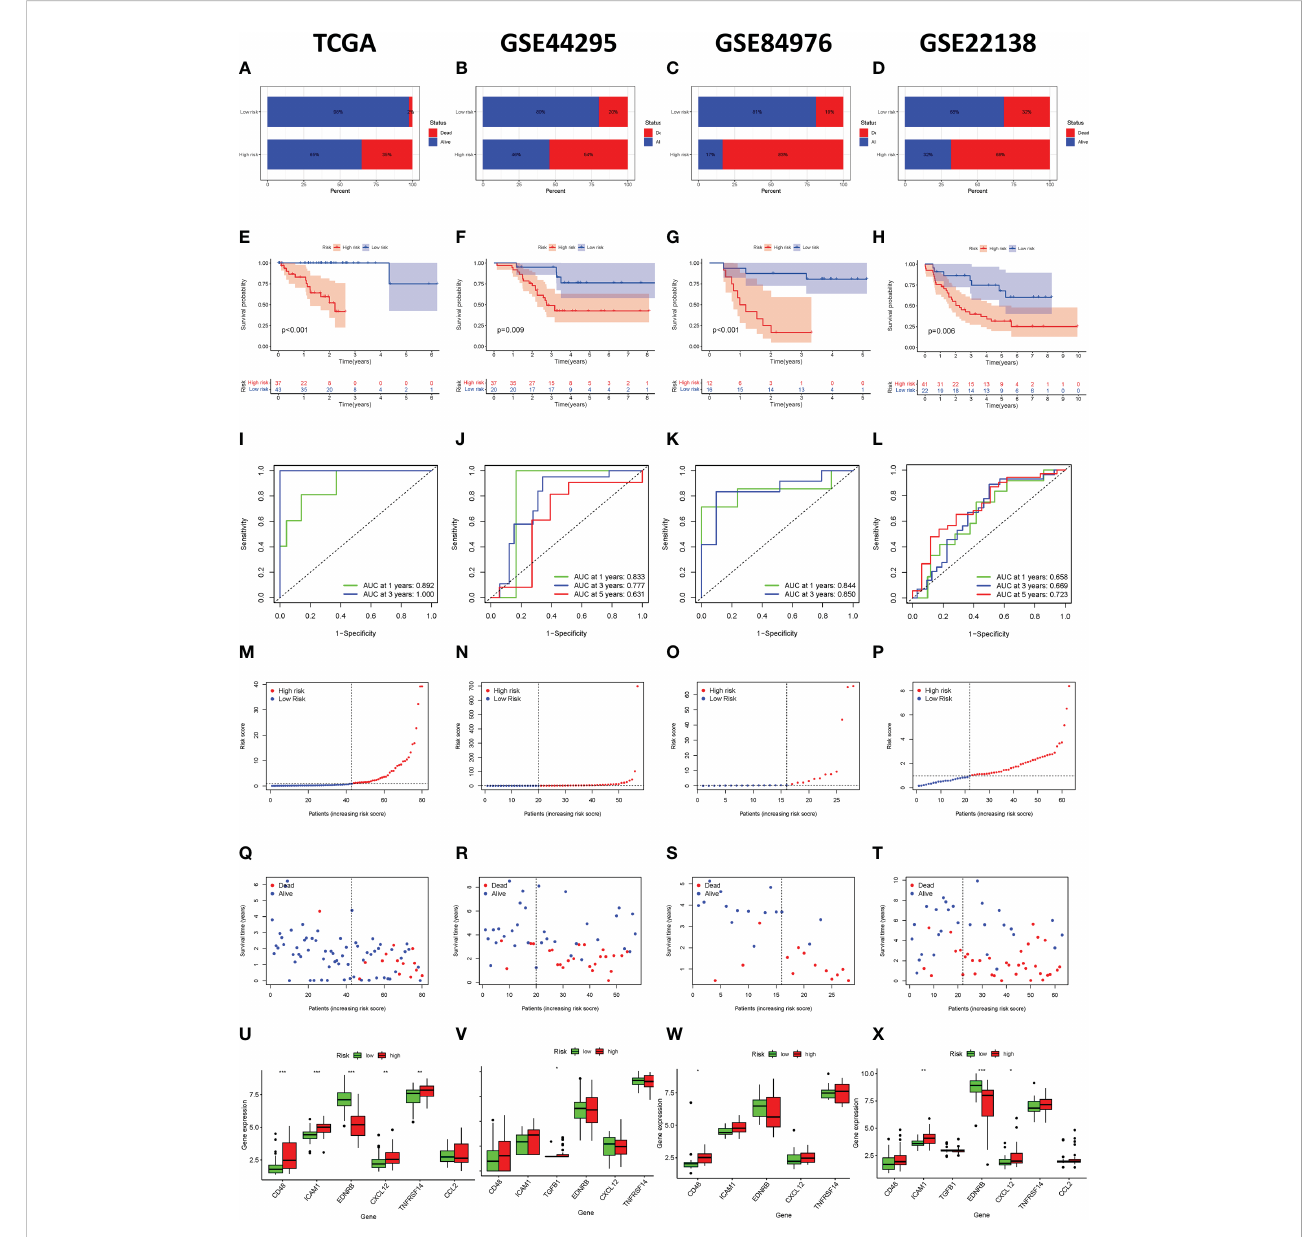
FIGURE 4 Immune-related gene prognostic signature used to predict outcomes in the TCGA set and GEO set. Survival status of patients in the high-risk and low-risk groups in the TCGA set (A) , GSE44295 set (B) , GSE84976 set (C) , and GSE22138 set (D) . The Kaplan-Meier survival curves for patients with uveal melanoma in the TCGA set (E) , GSE44295 set (F) , GSE84976 set (G) , and GSE22138 set (H) . The time-independent ROC curve of the prognostic signature at 1-year, 3-year, and 5-year in the TCGA set (I) , GSE44295 set (J) , GSE84976 set (K) , and GSE22138 set (L) . The risk curve of each uveal melanoma sample is reordered by risk score in the TCGA set (M) , GSE44295 set (N) , GSE84976 set (O) , and GSE22138 set (P) . The scatter plot of the uveal melanoma samples survival overview in the TCGA set (Q) , GSE44295 set (R) , GSE84976 set (S) , and GSE22138 set (T) . The immunosuppressive cytokine expression in the high-risk and the low-risk groups in the TCGA set (U) , GSE44295 set (V) , GSE84976 set (W) , and GSE22138 set (X) . *p < 0.05, **p < 0.01, ***p <